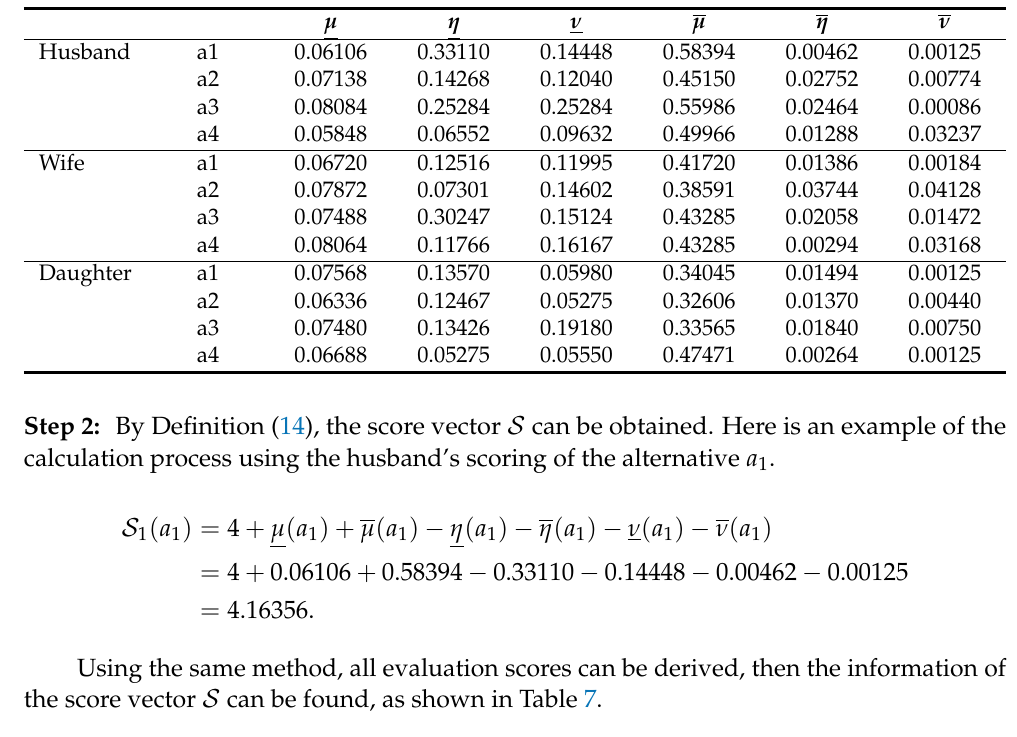
Table 6. Information of the NFSRSs vector R ( F ) .